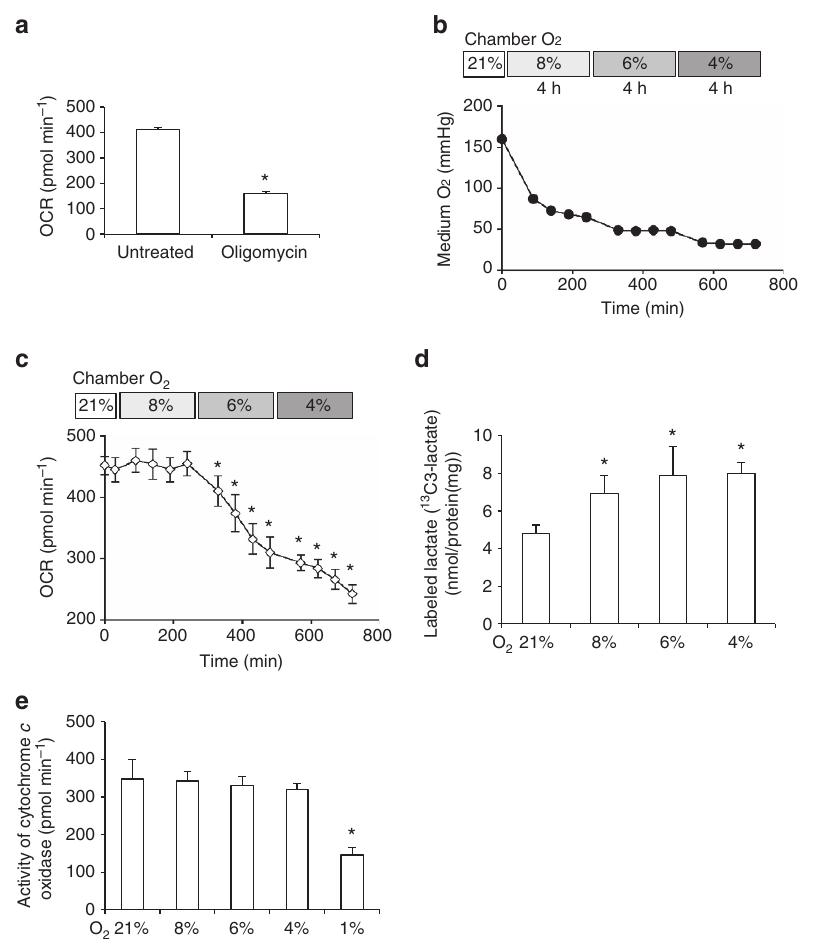
Figure 1 | The glycolytic reprogramming of primary macrophages in mildly hypoxic condition. ( a ) The reduction of OCR by oligomycin (0.5 m M) to wild-type TEPMs. ( b ) The oxygen concentrations in assay medium were calibrated with XF24 Extracellular Flux Analyzer (8% O 2 , 4h-6% O 2 , 4h-4% O 2 , 4h). ( c ) OCR of wild-type TEPMs was plotted as pmolmin (cid:2) 1 ( y axis) versus time ( x axis; 8% O 2 , 4h-6% O 2 , 4h-4% O 2 , 4h). ( d ) The lactate production in TEPMs was calculated with capillary electrophoresis (CE)-electrospray ionization (ESI)-mass spectrometry (MS; 8% O 2 , 4h-6% O 2 , 4h-4% O 2 , 4h). n ¼ 5 animals. ( e ) The cytochrome c oxidase activity of TEPMs was calculated as OCR in the presence of ascorbate (100mM) and TMPD (1mM; 8% O 2 , 4h-6% O 2 , 4h-4% O 2 , 4h-1% O 2 , 4h). All graphs indicate average with s.d. All experiments using XF24 were repeated three times. TEPMs were collected from wild-type C57BL6 mice ( a , c ) and from Tie2-Cre (cid:2) / (cid:2) HIF-1 a flox/flox mice ( d , e ). Student’s t -test was performed to calculate P value. * P o 0.05 versus control (21% O 2 ); 8, 6, 4 and 1% O 2 concentration,